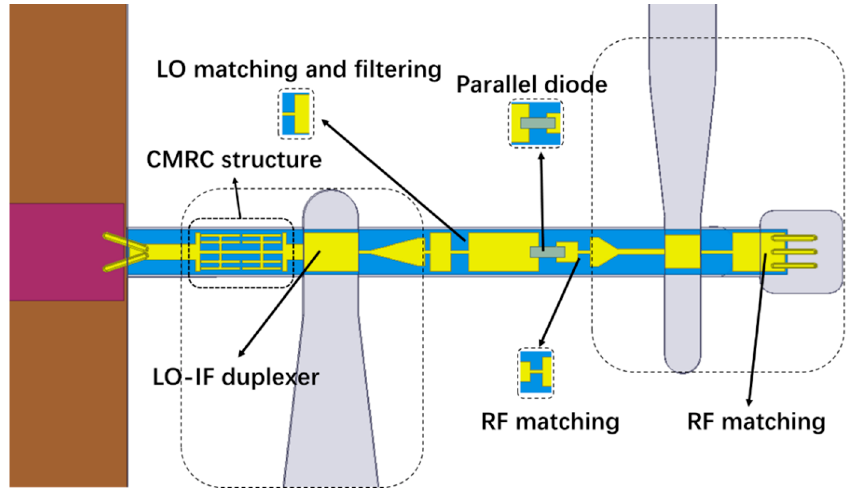
Figure 3. Schematic diagram of the split circuit.